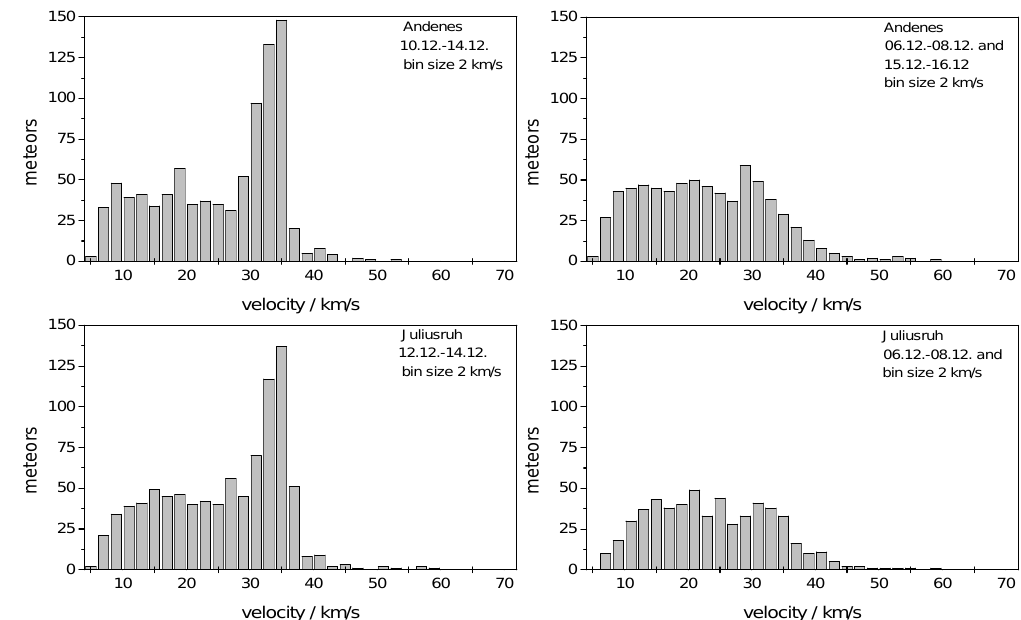
Fig. 5. Meteor velocity histograms for different periods during the ECOMA campaign for the Andenes MR (top panels) and Juliusruh MR (bottom panels).